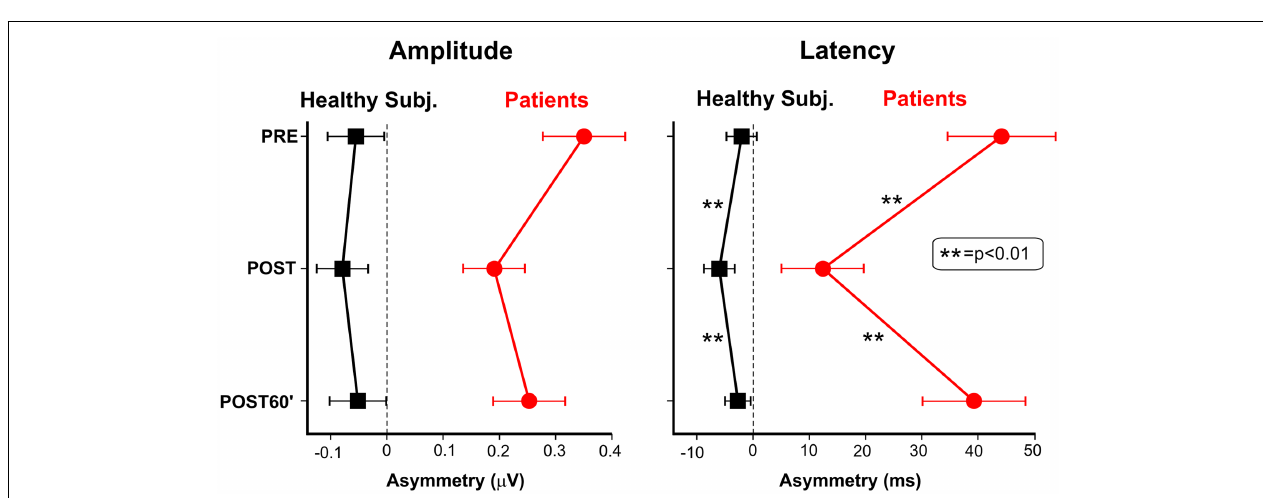
LVF responses measured in the three conditions (PRE, POST, and POST60 (cid:48) ). The left panel shows theTENS effect on the amplitude at the peak temporal frequency (7.5Hz).The right panel shows theTENS effect on apparent